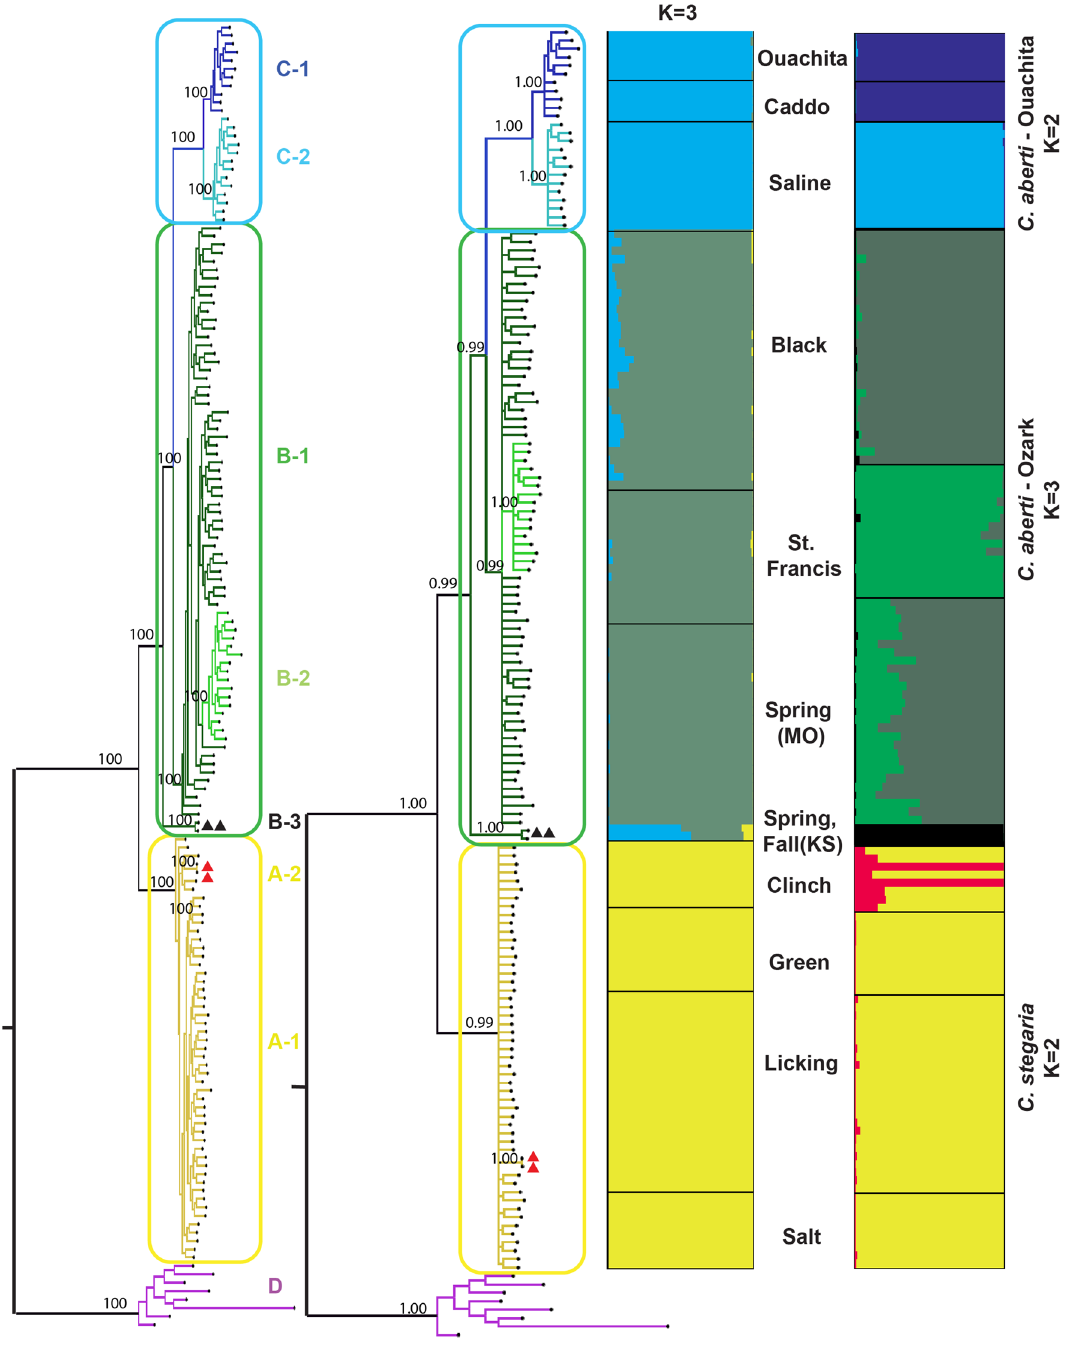
Figure 3. Phylogenetic relationships and population genetic composition of freshwater mussel species. Maximum likelihood (ML) tree (left) and Bayesian tree (right) were constructed based on 4395 informative sites from concatenated sequences of 9673 SNPs (see text for details). Bootstrap support values (ML) and posterior probability (Bayesian) respectively were provided at the node of major clade. The STRU CTU RE plots show the posterior probability for individual assignments of samples to different genetic clusters. The main plot (left) shows the results for the optimal number of genetic clusters (K = 3) for 148 Cyprogenia specimens. The three smaller plots to the right show the results of re-analyses of samples from each Highland. The optimal number of genetic clusters was K = 2 for Ouachita, K = 3 for Ozark, and K = 2 for Eastern. Colors of clusters in the phylogenetic trees correspond to colors in the STRU CTU RE plots and Fig. 2. Red triangles: Clinch river, TN (Eastern15 and Eastern18 in Table S1), Black triangles: Spring and Fall rivers, KS (Ozark105 and Ozark107 in Table